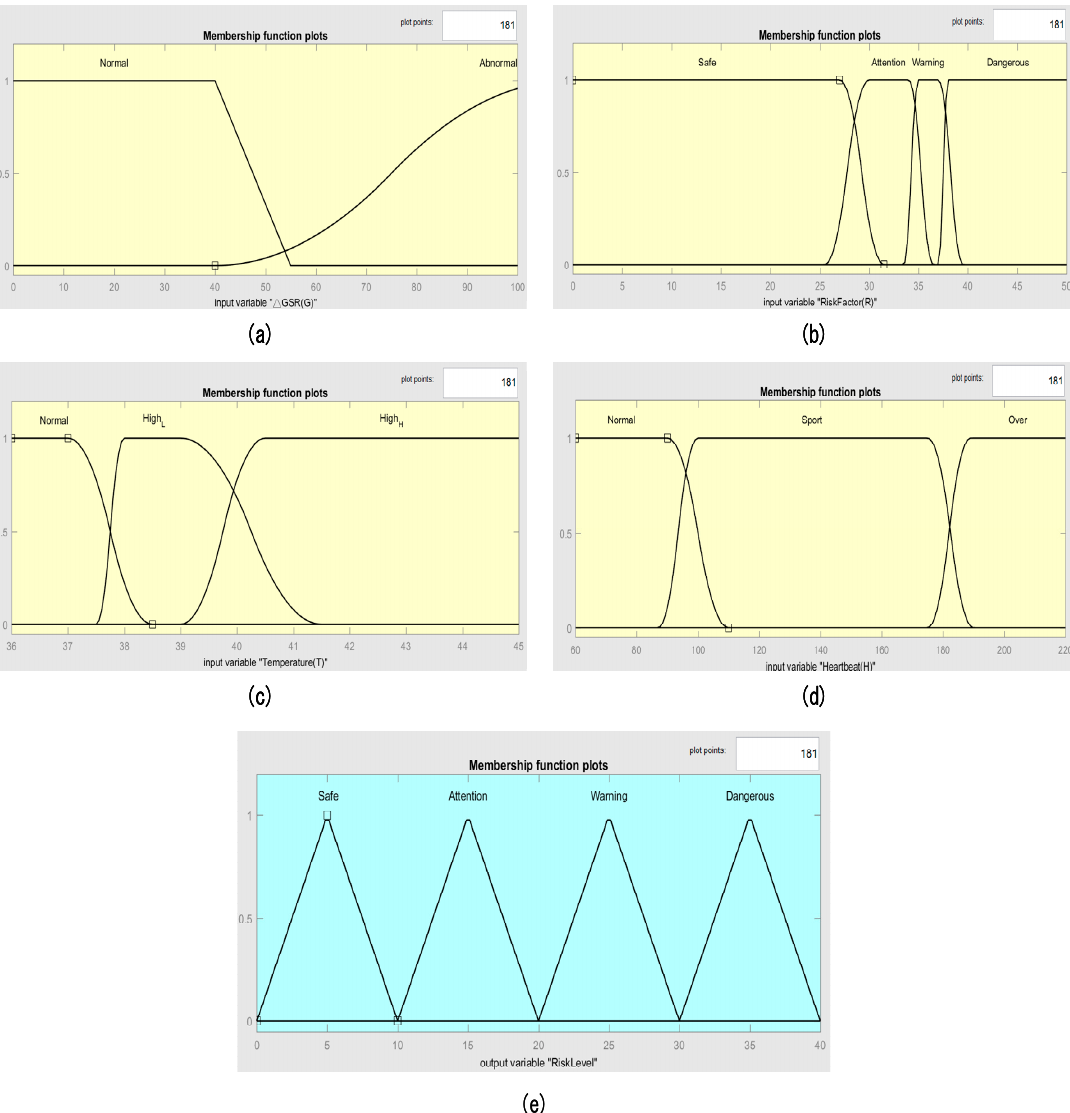
Figure 8. Membership function plot. ( a ) Galvanic skin response (GSR), ( b ) risk coefficient, ( c ) body temperature, ( d ) heartbeat, and ( e ) risk level.